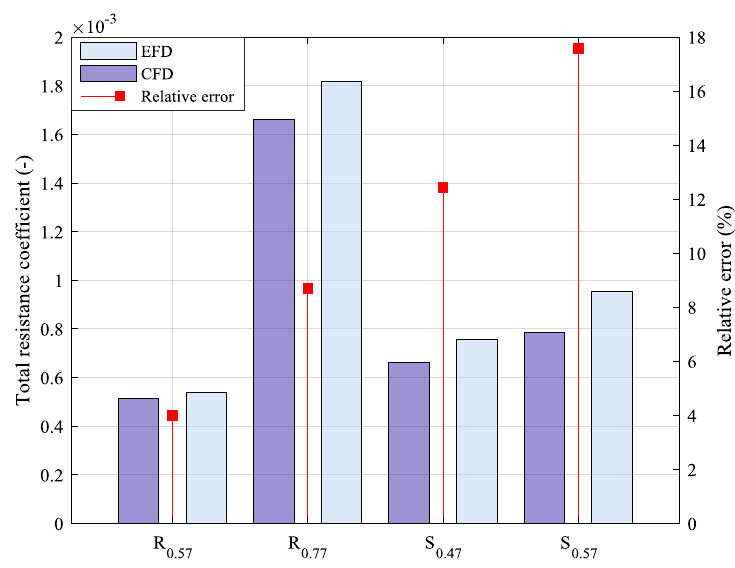
Figure 8. Comparison of total resistance coefficients for all cases (R indicates the rectangular canal case, whereas S indicates the Suez Canal). Subscripts refer to depth Froude number. Relative error computed as (EFD − CFD)/EFD × 100.